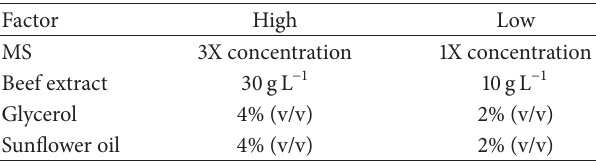
Table 1: High and low design of experiments—RSM media optimi-